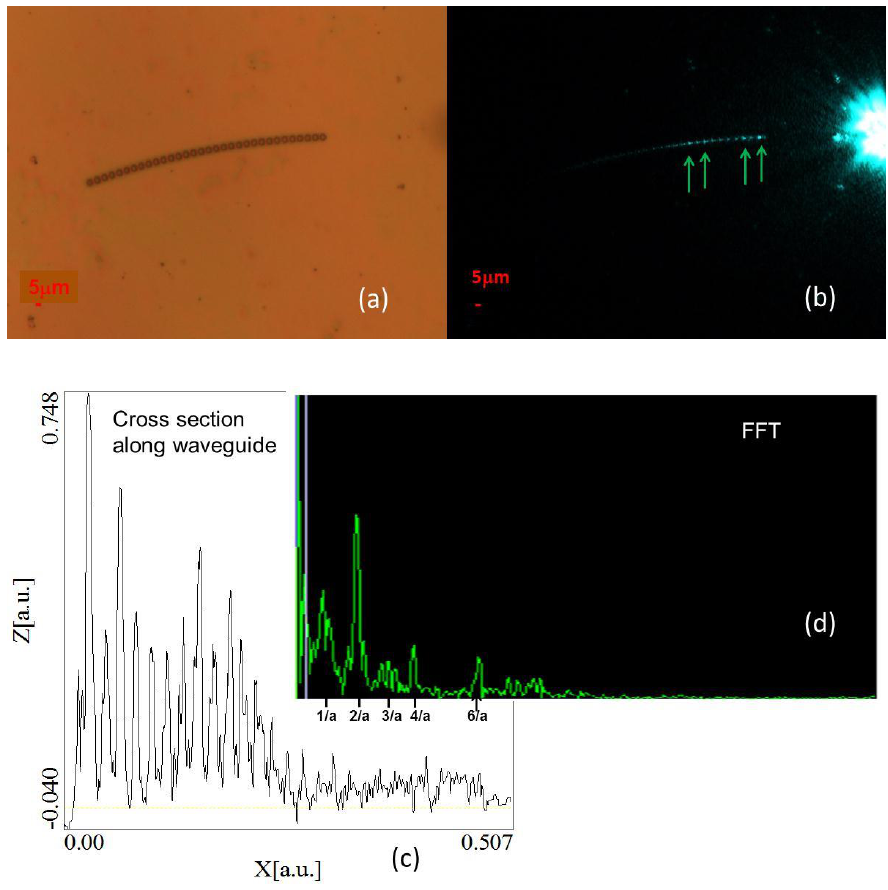
Figure 6. Experimental analysis of TM light propagation through a curved Luneburg waveguide: ( a ) Microscopic image of the fabricated curved Luneburg waveguide. ( b ) Microscopic image of the same waveguide regions taken while 515 nm light was coupled into the waveguide. Double periodicity of light distribution in the waveguide is indicated by arrows. ( c ) Cross-section of image (b) measured along the waveguide demonstrates that similar to theoretical simulations in Figure 3c double periodicity along the curved waveguide is broken. ( d ) FFT analysis of the cross section in (c) indicates that the double and the other even periods dominate light distribution inside the curved Luneburg